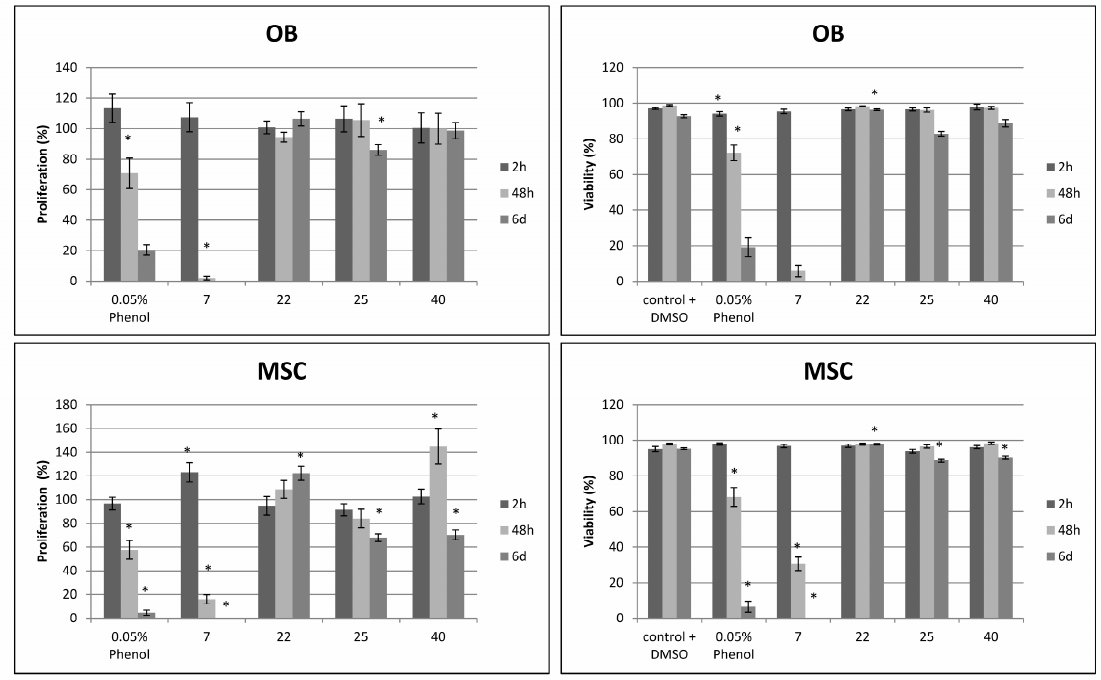
Figure 5. Effect of selected compounds (12.5 µM) on the proliferation and viability of osteoblasts (OB) and mesenchymal stem cells (MSC) after 2 h, 48 h and 6 days of exposure, as determined by trypan blue staining. Negative controls were cell culture medium and cell culture medium with 0.5% DMSO solvent background, positive control was 0.05% phenol to show a cytotoxic effect. % Proliferation is defined as: (total viable cells in treated sample/total viable cells in solvent control) × 100. % Viability is defined as: total viable cells (unstained)/total cells (stained + unstained) × 100. Bars and error bars represent resp. means and standard errors of 8 repeats. Significant differences ( p < 0.05) with the negative solvent control are indicated with an asterix